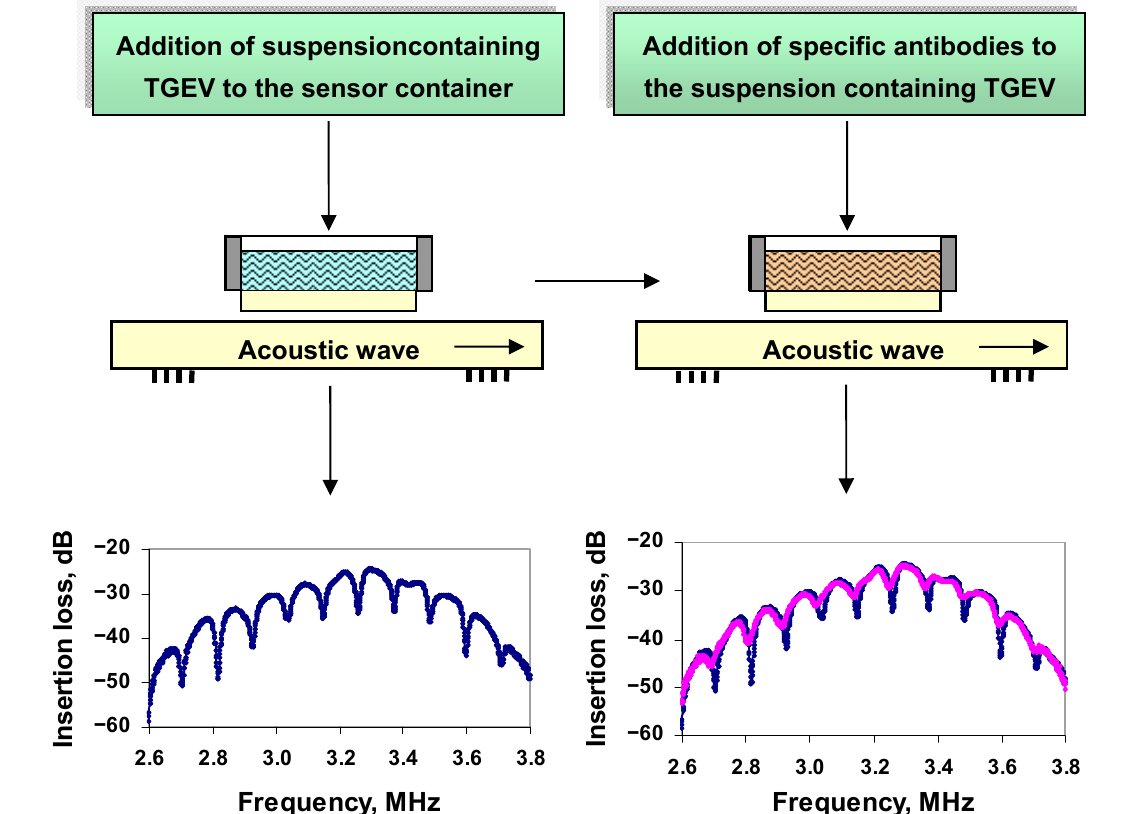
Figure 4. Scheme of the experiments with an acoustic sensor.